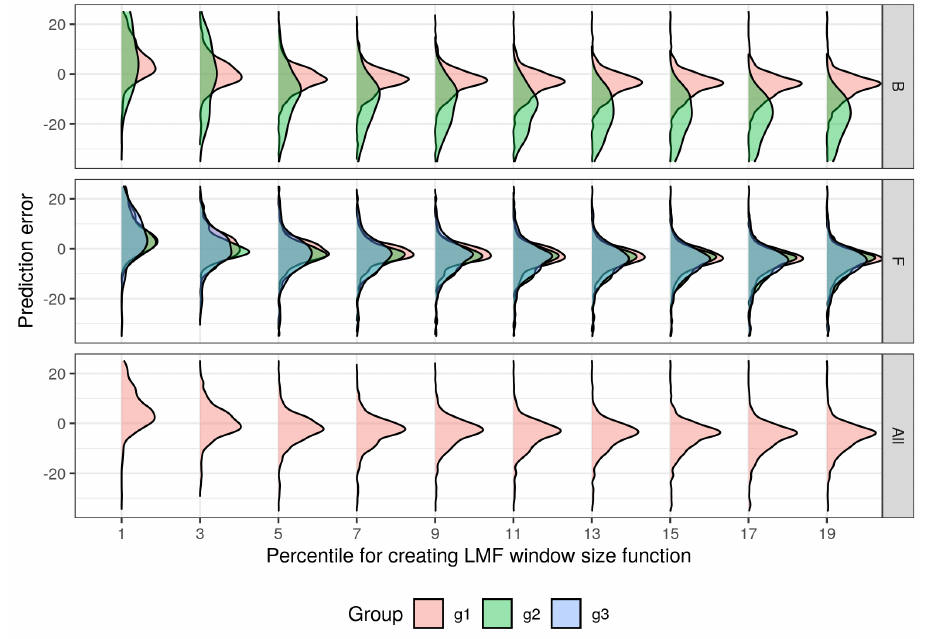
Figure 9. Distribution of estimation error of number of trees on sample plots over B category groups (sample plot size g1: r ≤ 12.62 m and g2: r > 12.62 m), F (crown visibility ratio—ratio of partially visible crowns of trees to fully visible crowns of trees—g1: less than 10%, g2: between 10% and 20%, and g3: over 20%) category groups and all sample plots dependent on the Local Maximum Filter method parameterization.